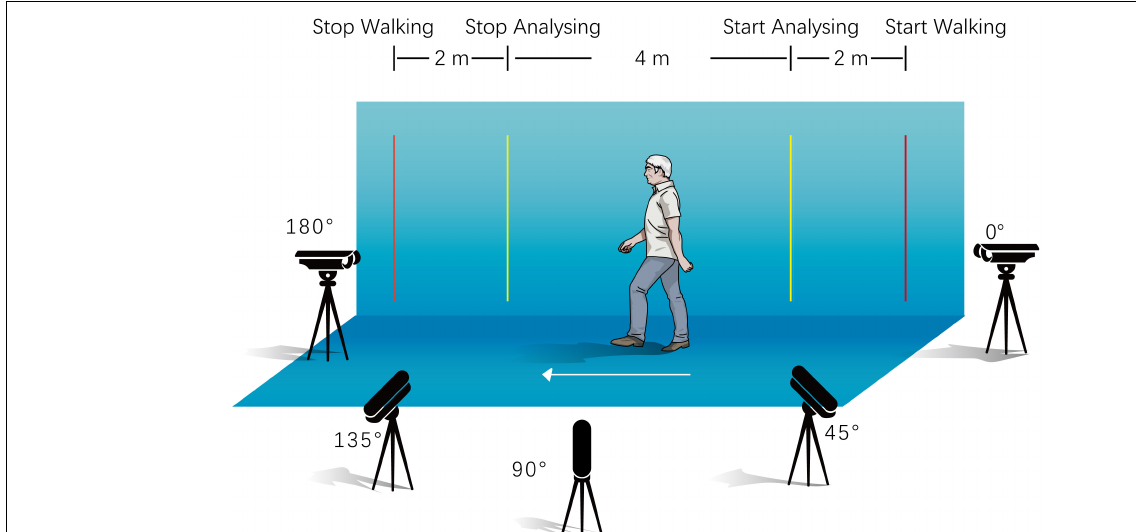
FIGURE 2 | Recording of walking video.